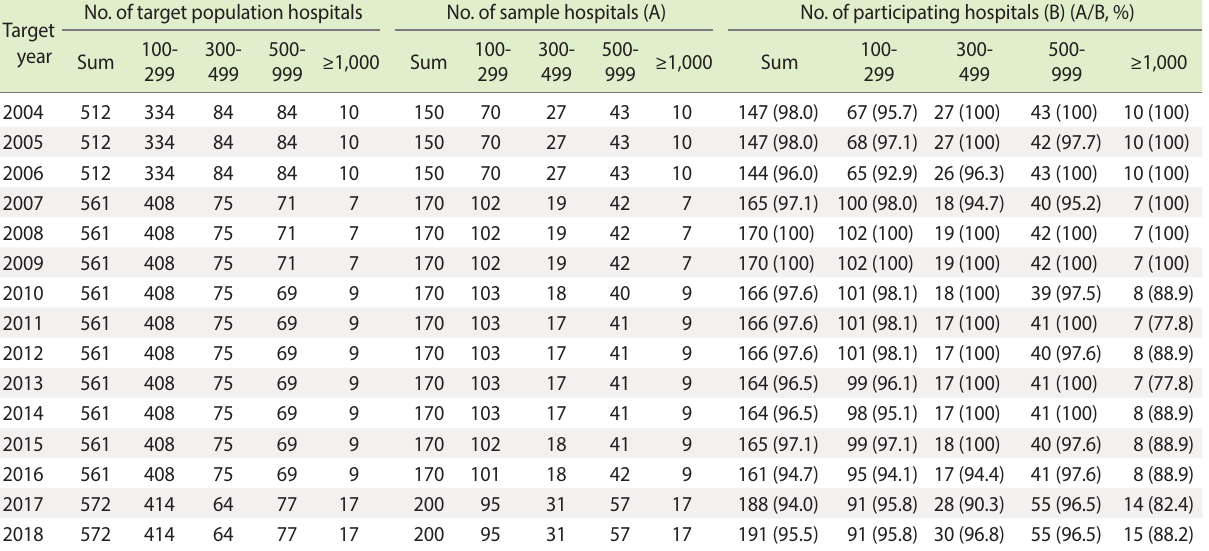
Table 1. The number of sampled hospitals, their rates of participation, and the number of surveyed cases in the KNHDIS